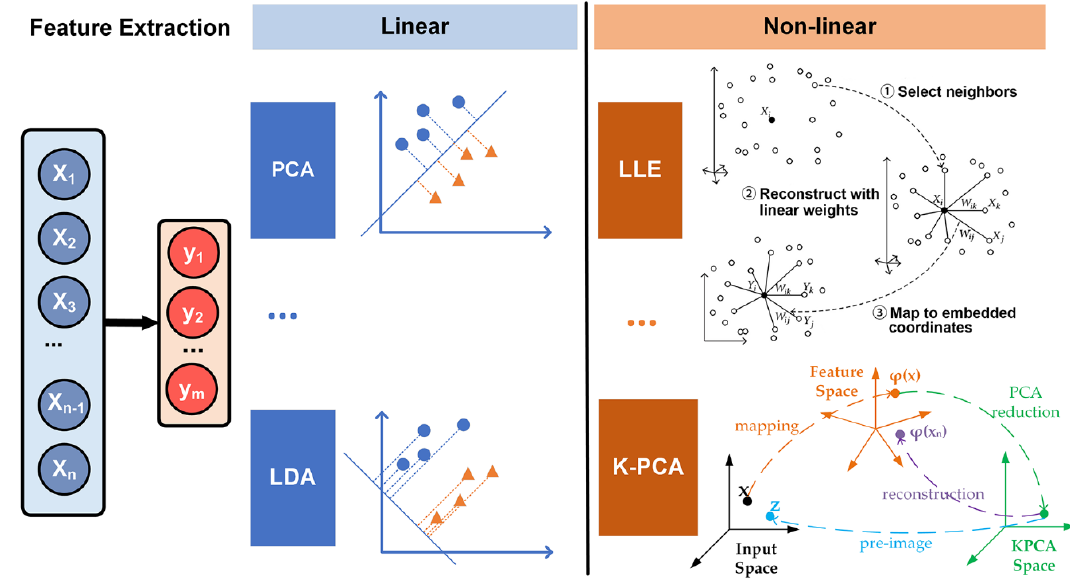
Figure 4. Different feature extraction methods used in ECG analysis. Figure 4. Di ff erent feature extraction methods used in ECG